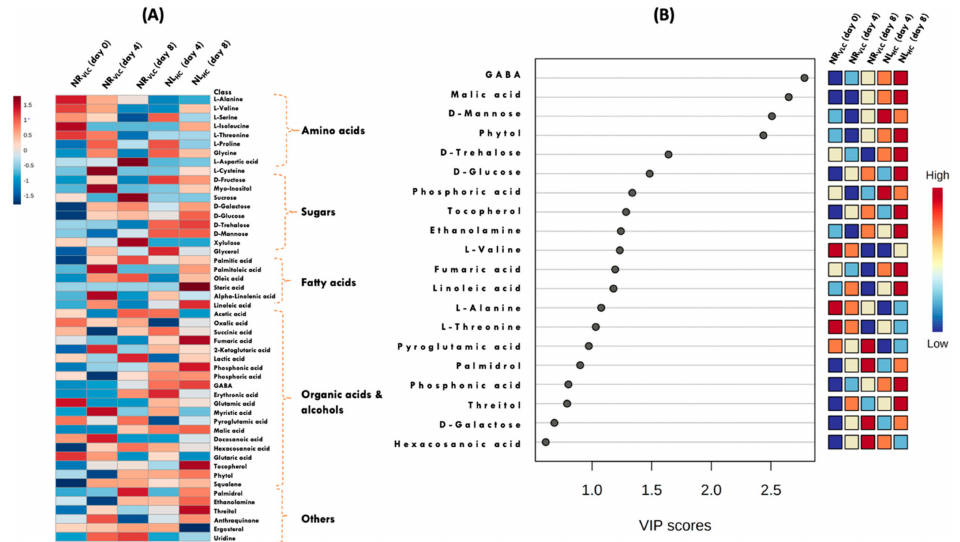
Figure 4. ( A ) Heat map depicting the time-course qualitative (untargeted) metabolomics on the 4th and 8th days of the native isolate Monoraphidium sp. CABeR41 subjected to NR VLC and NL HC condi- tions. ( B ) Variable Importance in Projection (VIP) score plot representing the significant metabolites subjected to NR VLC and NL HC